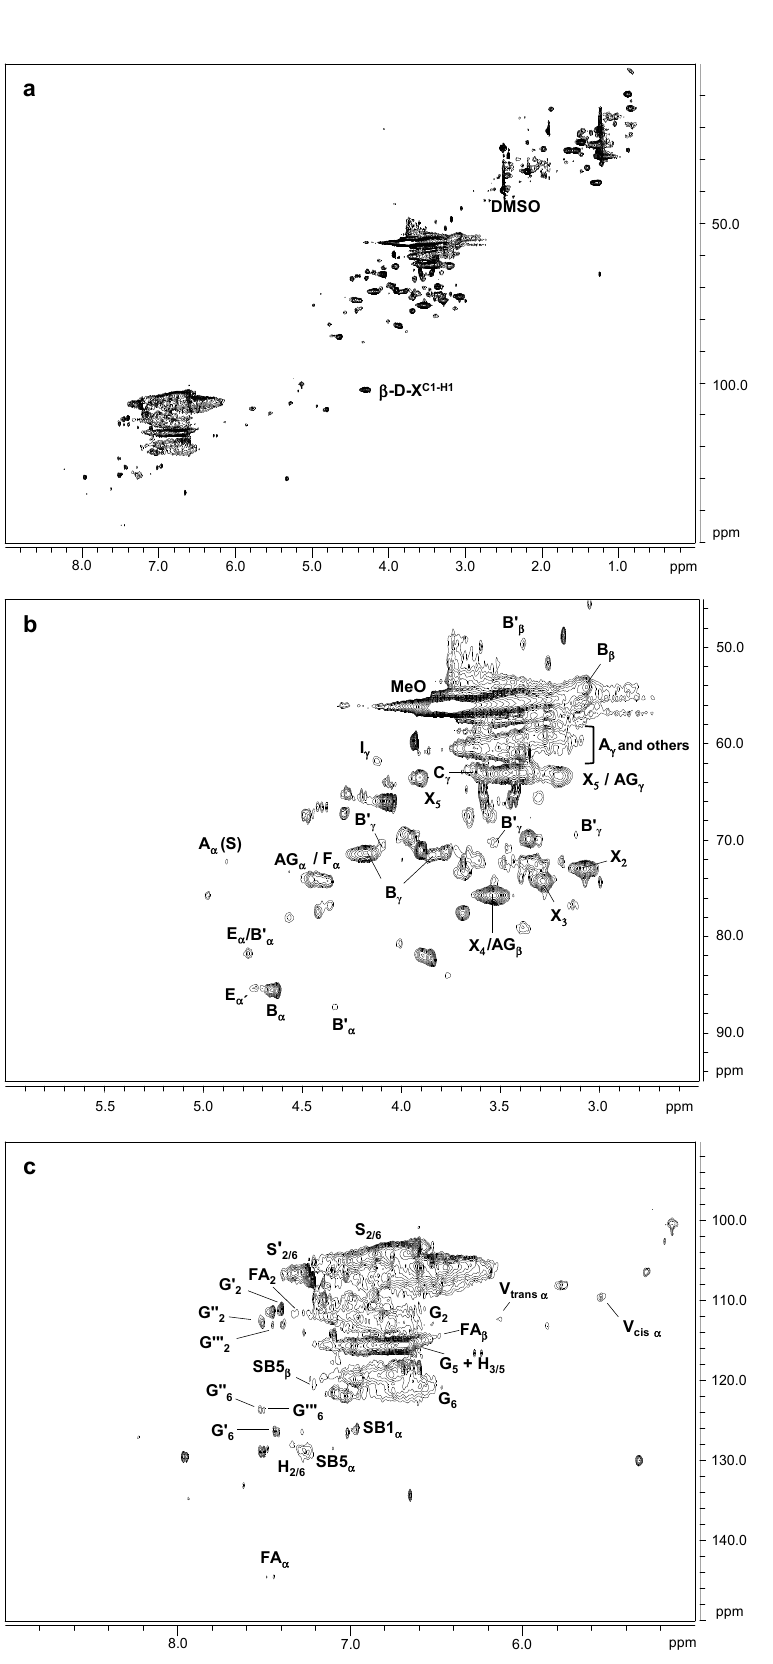
Figure 3. HSQC 2D-NMR spectra of soda/AQ-orange lignin. ( a ) whole spectrum, δ C / δ H 0.0–150.0/0.0–9.0; ( b ) aliphatic oxygenated region, δ C / δ H 45.0–95.0/2.5–6.0 ppm; ( c ) aromatic region, δ C / δ H 90.0–150.0/5.0–9.0 ppm.